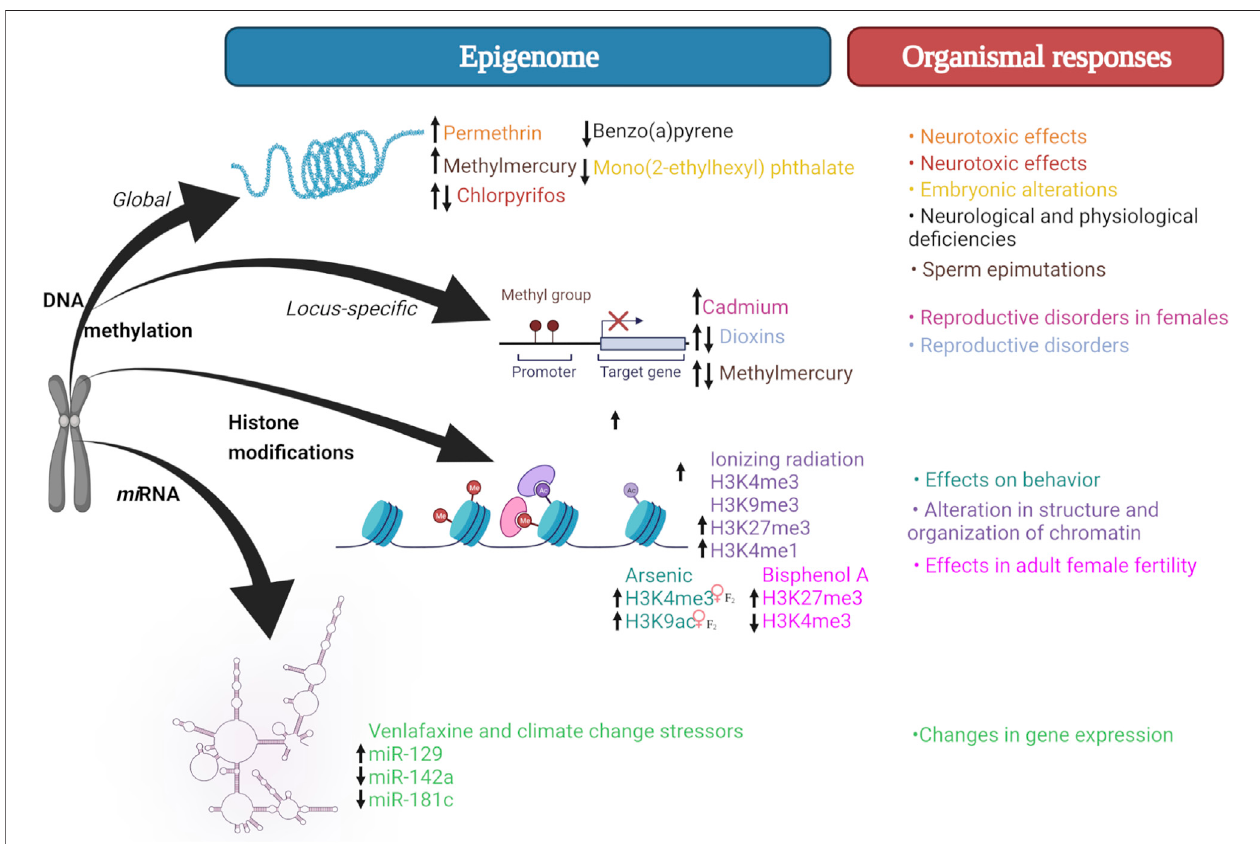
FIGURE 1 | Epigenetic mechanisms triggered by exposure to xenobiotics. Xenobiotic exposure may affect different epigenetic mechanisms, which in turn may result in phenotypic (e.g., neurotoxic, reproductive, behavioral) alterations. Created with BioRender.com.